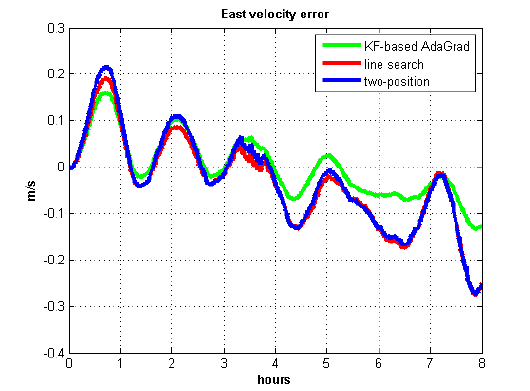
Figure 11. East velocity